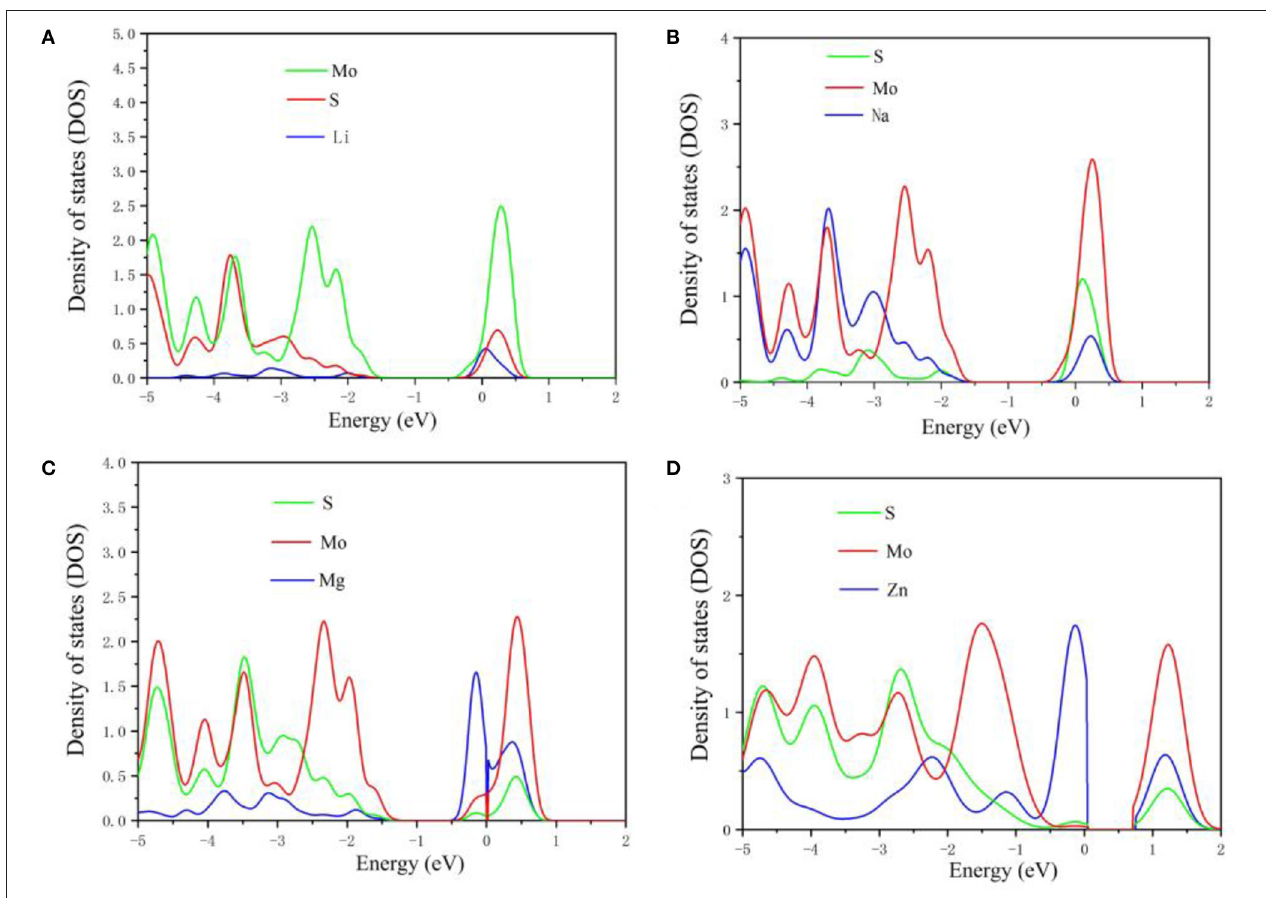
FIGURE 4 | The projected density of states in MoS 2 structure during Li (A) , Na (B) , Mg (C) , and Zn (D) intercalation.